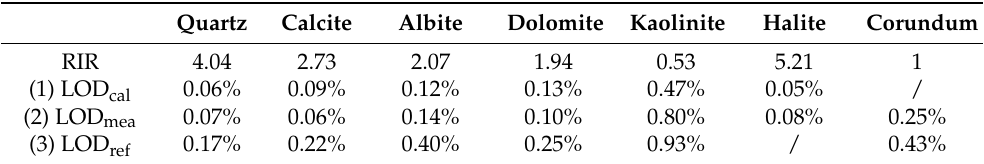
Table 2. The limits of detection (LOD) for minerals used in this study. LOD cal is calculated LOD value; LOD mea is measured LOD value in the experiment; LOD ref refers to LOD value from Hillier’s experiment [35].